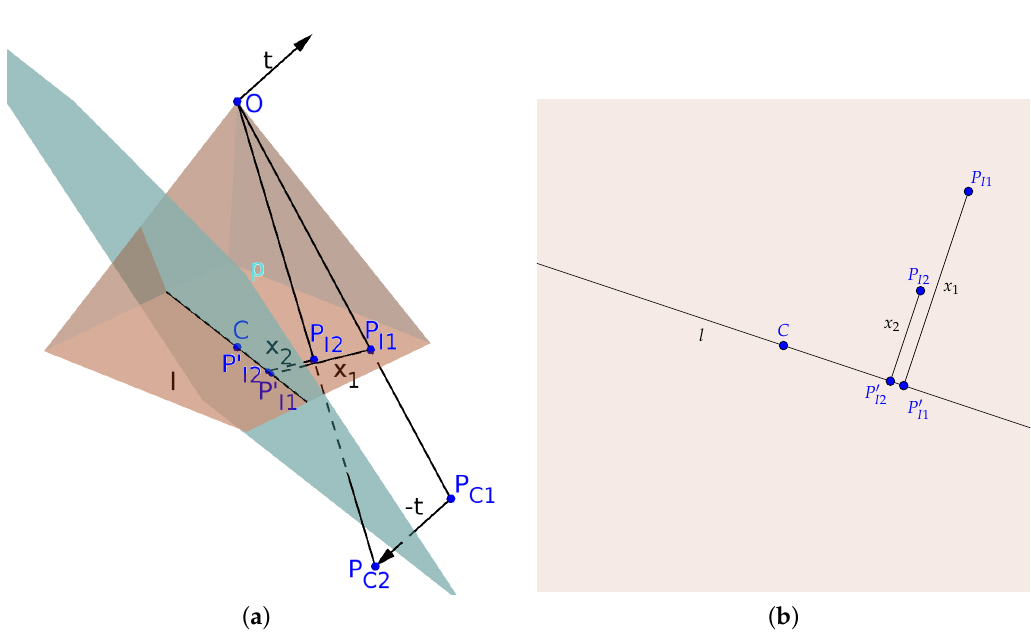
Figure 3. Adapted stereo schematics for 3D motion. ( a ) The projection of a point P W in two consecutive Figure 3. Adapted Stereo Schematics for 3D motion. (a) shows the projection of a point P W in two images after a camera motion represented by (cid:126) t . For viewing purposes we aligned both camera frames consecutive images after a camera motion represented by ~ t . For viewing purposes we aligned both (cid:126) t , represented in the camera coordinate system as points P and displaced the point P W by ~ t , represented in the camera coordinate system as C 1 and P C 2 camera frames and displaced the point P W by − − for the first and second frame, respectively; these points are then projected onto the image plane as points P C 1 and P C 2 for the first and second frame respectively, these points are then projected onto the points P I 1 and P I 2 ; ( b ) the image plane. ( a ) Projection schematic; ( b ) image image plane as points P I 1 and P I 2 . (b) the image plane.